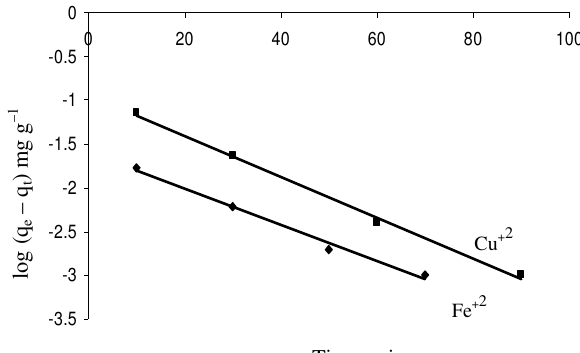
Figure 3 . Plot of time versus log (q fruit powder.